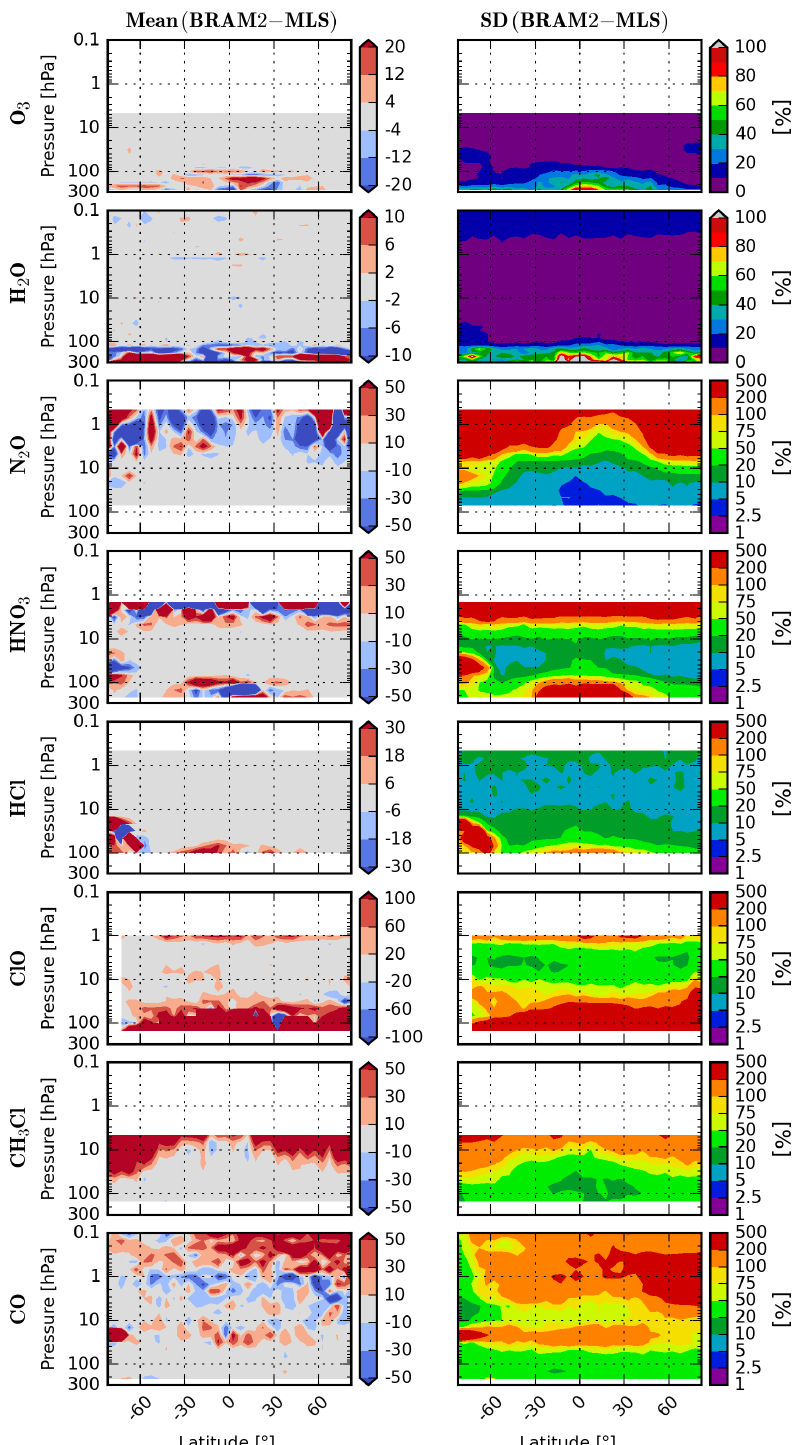
Figure 4. Daily zonal mean differences (%) between BRAM2 and MLS (left column) and the associated standard deviation (right column) on 1 September 2009. From top to bottom: O 3 , H 2 O, N 2 O, HNO 3 , HCl, daytime ClO, CH 3 Cl and CO. Zonal means are calculated on the MLS pressure grid and binned on a 5 ◦ latitude grid. Note that the ranges in the colour bars differ for each individual plot and that some colour bars are on a log